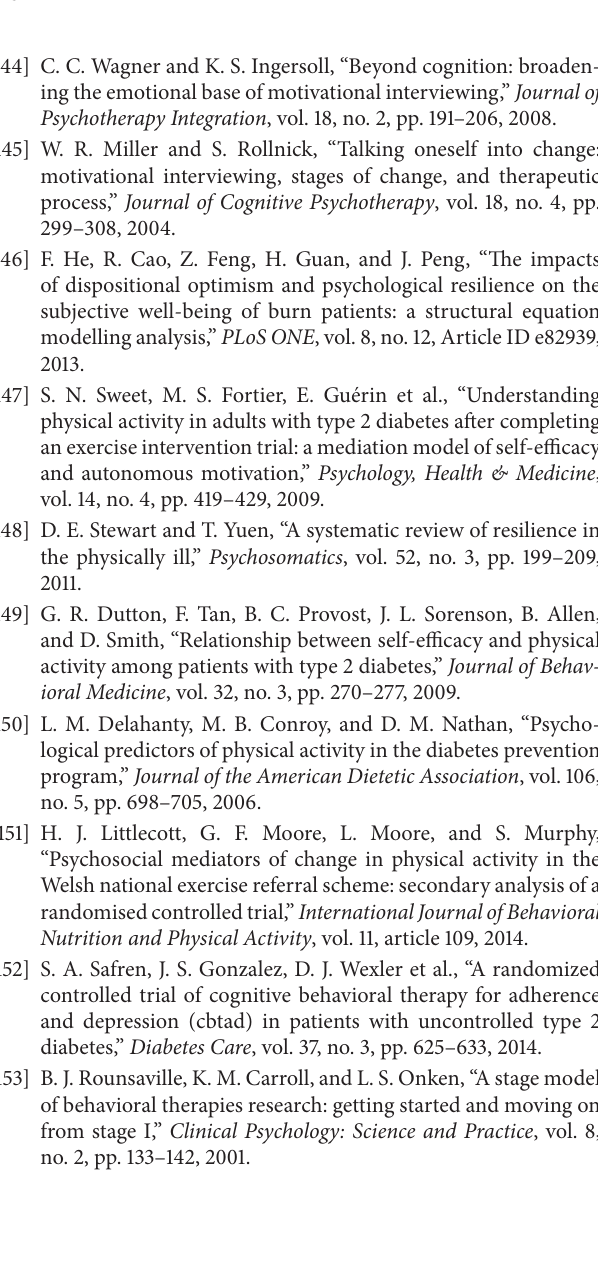
Welsh national exercise referral scheme: secondary analysis of